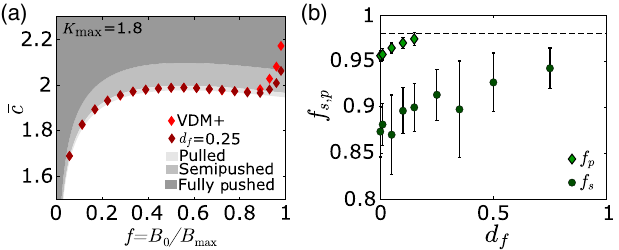
FIG. 14. (a) Dimensionless front velocity ¯ c of the VDM þ as a function of the bacteria fraction f and debris fraction d f , with shaded regions indicating the different expansion types. As in Fig. 2(c), parameters are chosen to represent typical T7 expan- ¼ 0 . 1 min − 1 sions with β ¼ 50 , τ ¼ 18 min, and α B max ¼ 1 . 8 in our model. [21,32,35] corresponding to K max (b) Dependence of the critical bacteria fractions f s and f p , ¯ B ¯ V FIG. 15. Population concentrations , I; and at time ¯ t ¼ ¯ t where transitions occur, on d f . The dashed line indicates the max for a debris fraction d f ¼ 0 . 25 . The front is propagating with upper bound of f for which results are computed. We expect fully dimensionless velocity ¯ c to the right. It can be seen that behind pushed transitions to continue to occur above this threshold for the expansion front the density of the viral population is quite some time as d f is low. Inset shows the density of the viral population at ¯ x ¼ 0 and ¯ t ¼ ¯ t as a function of d f (i.e., it indicates the viral density in max the center of the plaque).